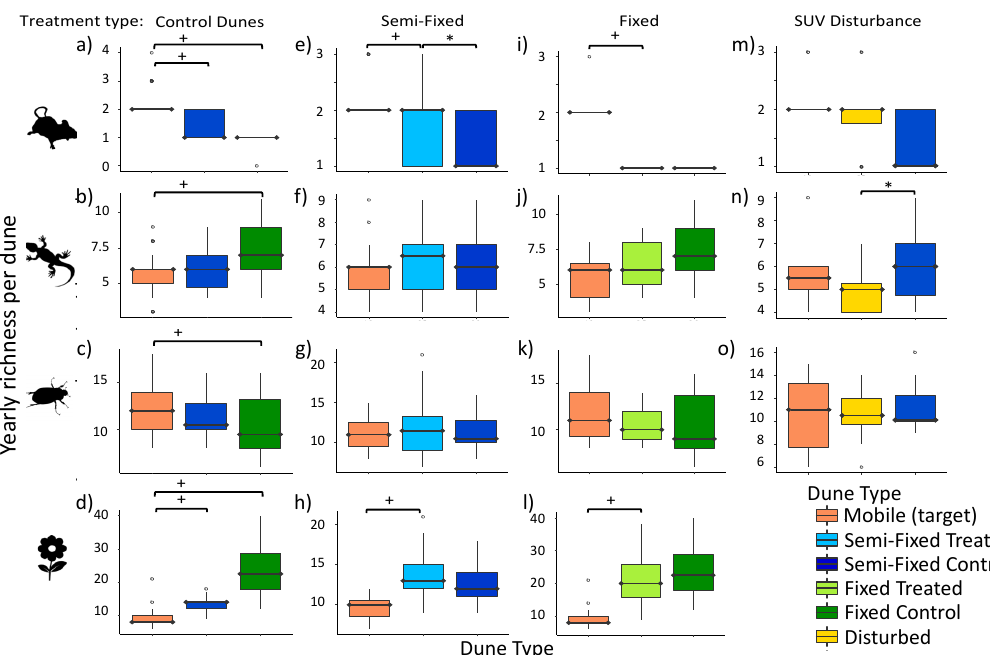
Figure 3. Boxplots of species richness for each taxon (see taxonomic icons for each row) in each dune treatment type (see column titles). Each treated dune type was tested against its untreated pair and reference (mobile) dunes. Disturbed dunes were not monitored for annuals and un ‐ treated semi ‐ fixed dunes were used as the control. Significant differences were tested with generalized mixed models for beetles and reptiles (Poisson), and linear mixed models for rodents and annuals. p < 0.05 for treated dunes compared to * control and + reference dunes, respectively.